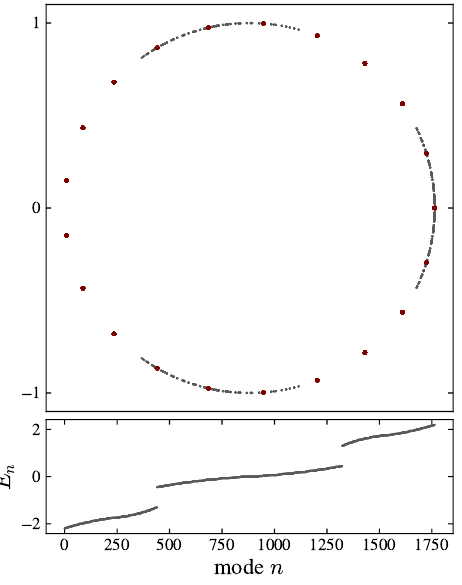
Figure 2: Quasienergies in the non interacting case, φ = 0 (black points). (top) Distribution on the unit circle for ( θ + , θ − ) = ( 3 π/ 7,2 π/ 9 ) . (bottom) The same quasienergies in increasing order, showing the band gaps. Red points are the eigenvalues of the quasimomentum P , whose eigenvectors are common to U , for a system size of L = 21. The gap arround E = 0 in the single particle system, splits into two gaps, as a consequence of the band wrapping characteristic of levels defined modulo 2 π